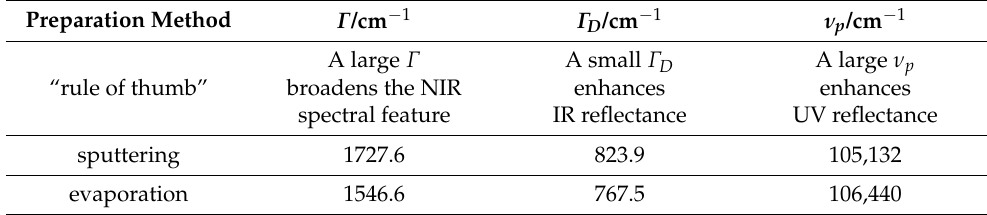
Table 8. Comparison of selected dispersion parameters of the sputtered and evaporated aluminum films with 29.7 nm thickness.